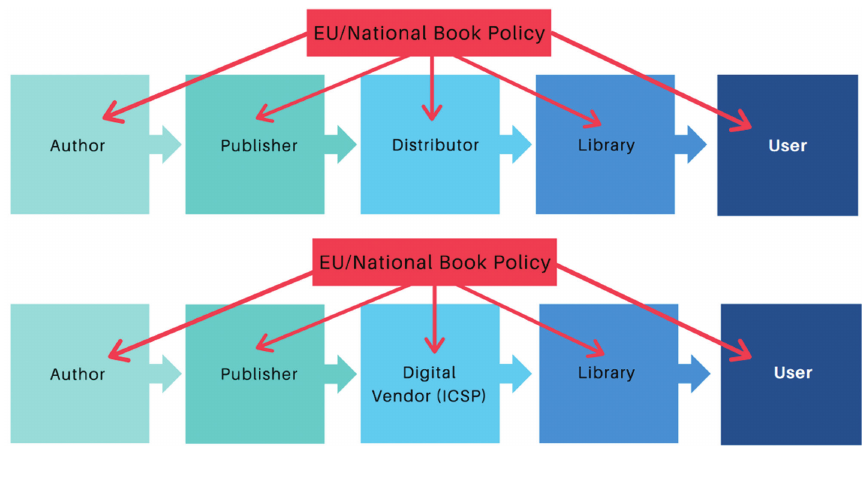
Fig. 2: General book trade (non-commercial distribution).